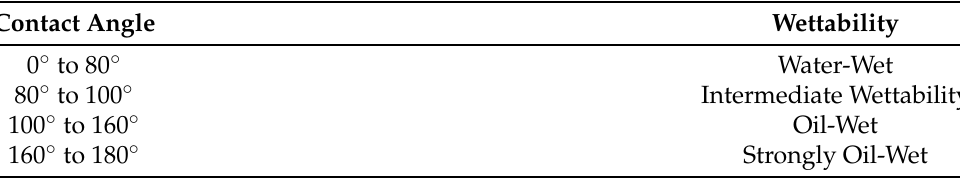
Figure 4. Sessile drop method; If θ < 90 ◦ , the system is water-wet; and if θ > 90 ◦ , the system is oil-wet. According to Chilingar and Yen [49], contact angles suggesting types of wettability for carbonate reservoirs are listed in Table 5. Table 5. Wettability classification of carbonate